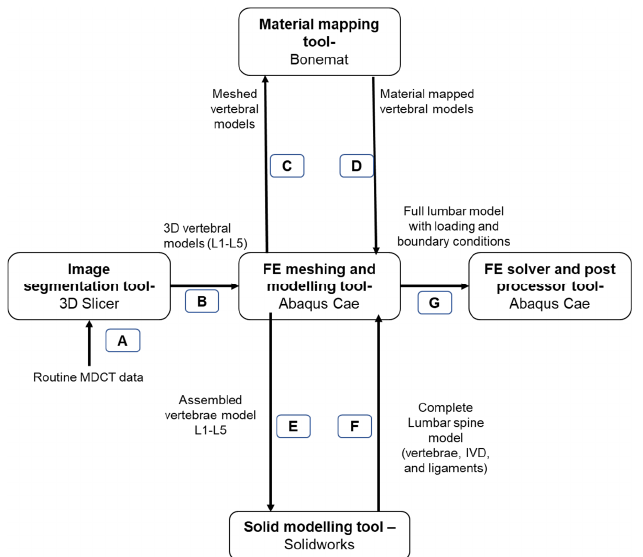
Figure 2. The flow of segmented models between different processing tools in the current compu- tational study. A—Importing the routine clinical data to image segmentation tool; B—Importing of segmented vertebral models to finite element (FE) preprocessor; C—Importing of meshed vertebral models to material mapping tool; D—Importing of material-mapped models to FE preprocessor; E—Importing of the assembled vertebral model to solid modeling tool for the generation of IVD and ligaments; F—Importing the complete lumbar spine model to FE preprocessor; G—Application of loading and boundary conditions to the lumbar model and importing to FE solver.